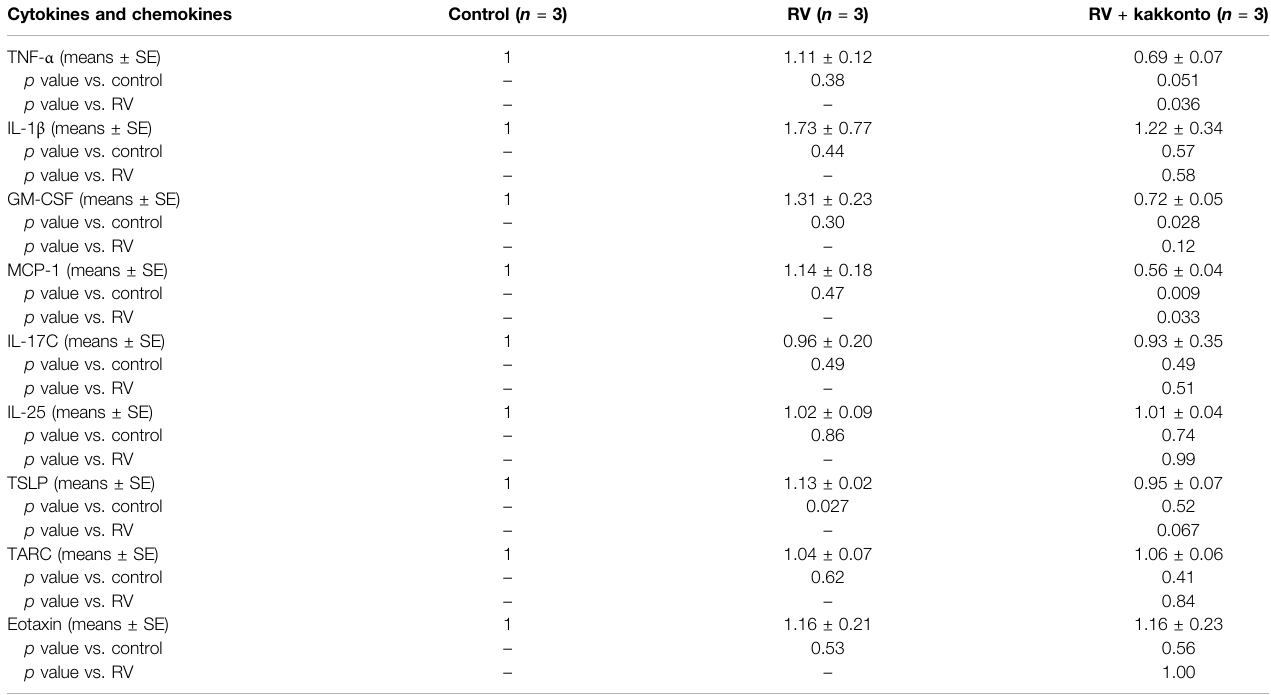
TABLE 4 | Cytokine concentration in the supernatants of HNE cells compared to control samples 24 h after RV infection. Cytokines and